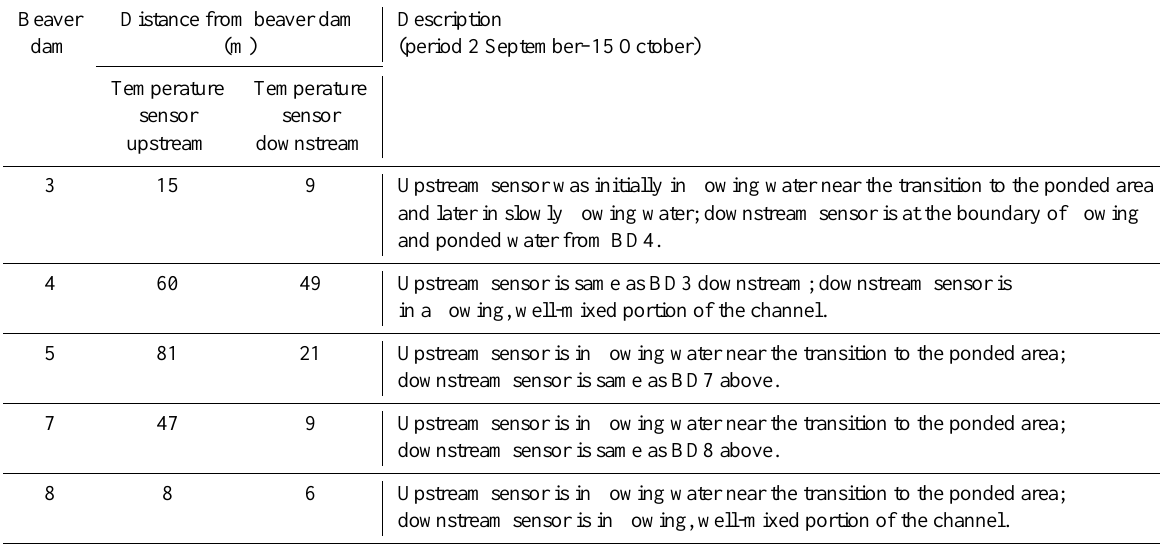
Table 2. Distance for temperature sensors located upstream and downstream of individual beaver dams (BD) during 2 September–15 October 2010 (Fig.